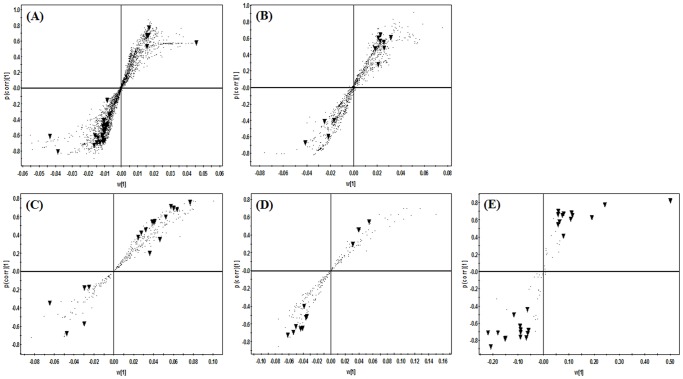
S-plots associated with OPLS-DA score plots derived from GC-TOF-MS (A, B), UPLC-Q-TOF-MS (C, D) and nanomate LTQ-MS (E) data sets for MW (A, C), DM (B, D) and lipid (E) extracts of mouse liver tissue after the exposure to UVB radiation for 6 weeks.The selected variables (▾, VIP>0.7 and p<0.05) are highlighted in S-plots. Each metabolites presented by a inverted triangle (▾) were the same metabolites presented in
Tables 3

–

5
.